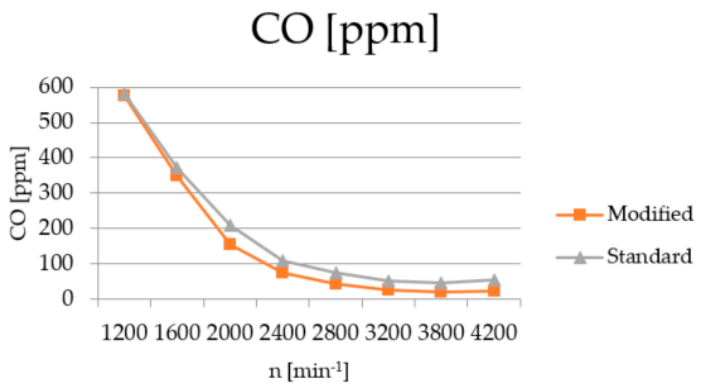
Figure 14. Carbon monoxide CO measurement results for the standard CR system and the modified CR system. Measurement error of exhaust fumes analyzer 1.5%.